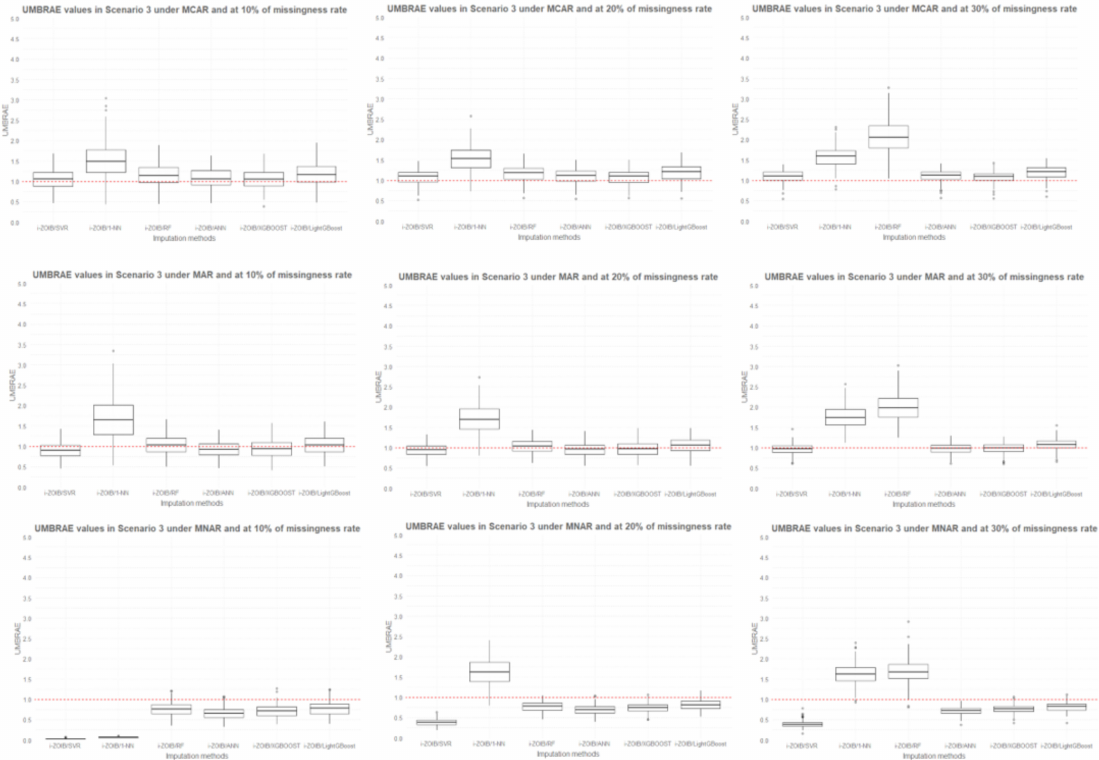
Figure 8. Boxplots of UMBRAE values according to the missingness mechanisms and rates in the Scenario